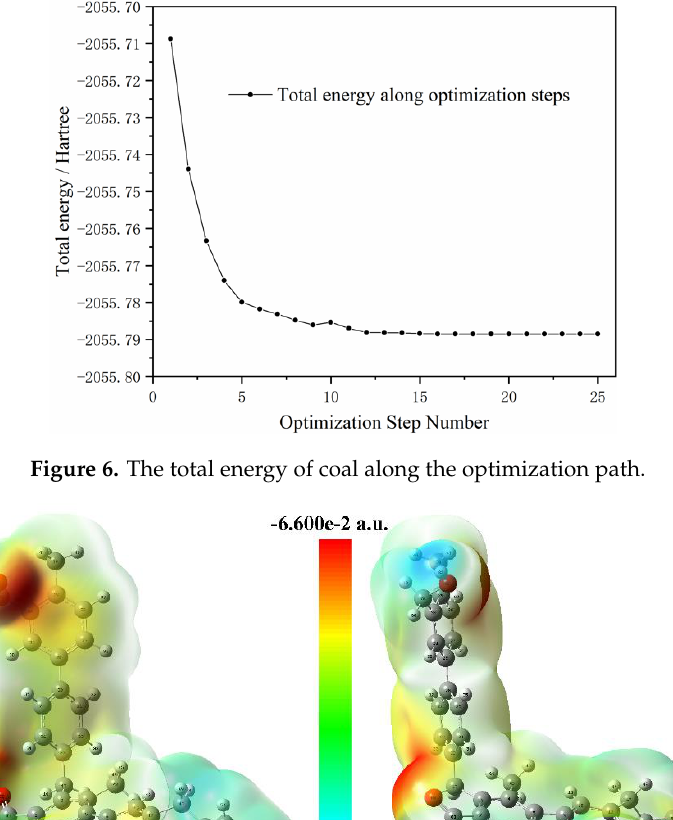
Figure 6. The total energy of coal along the optimization path.